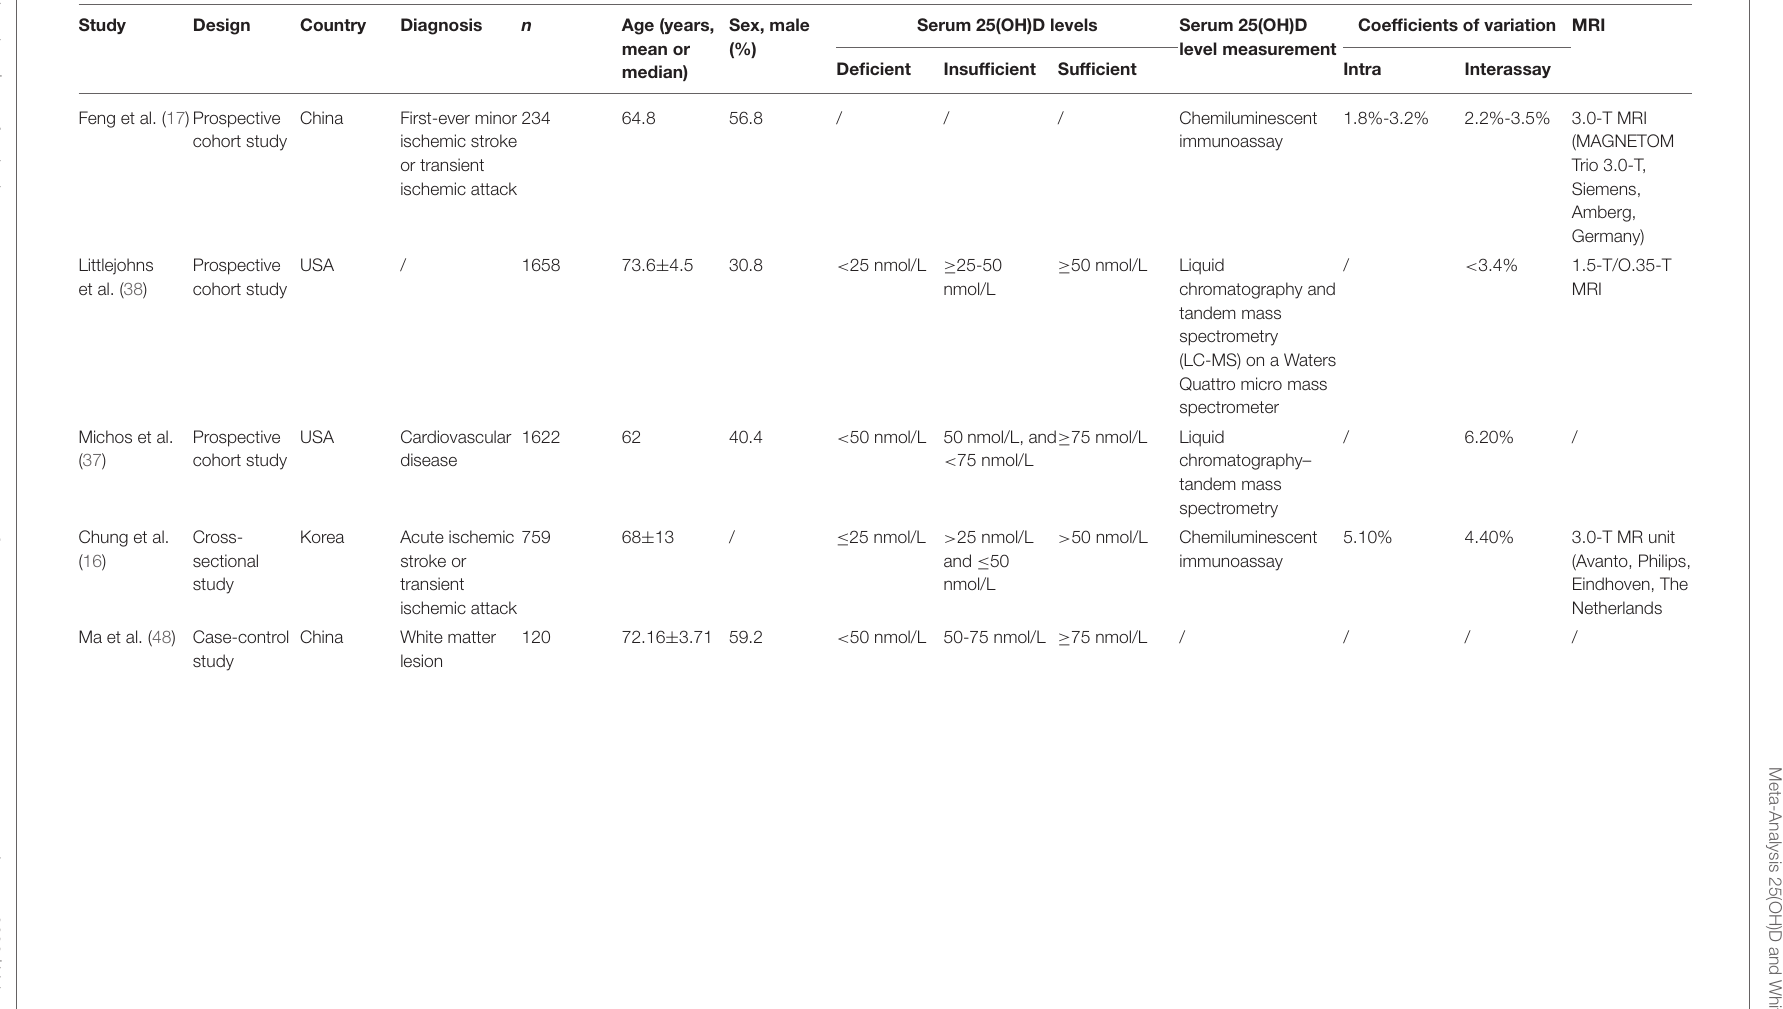
TABLE 1 | Literature search and characteristics of the included studies.